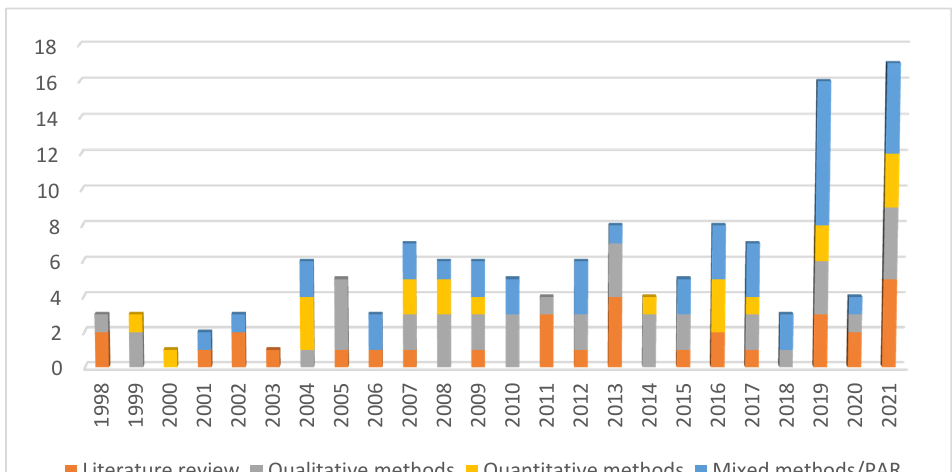
Figure 5. Research methodology by year of publication.